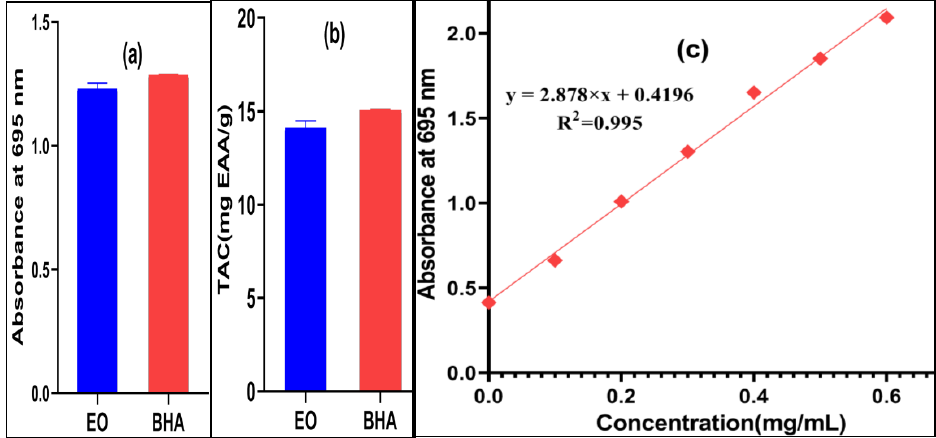
Figure 4. ( a )Absorbance at 695 nm, ( b ) total antioxidant capacity of the EO of O. elongatum and BHAstandard; ( c ) Regression curve of ascorbic acid. Table 2. Antioxidant activity of the EO of O. elongatum and BHA (Butylated_hydroxyanisole) measured by DPPH, FRAP and TCA methods.